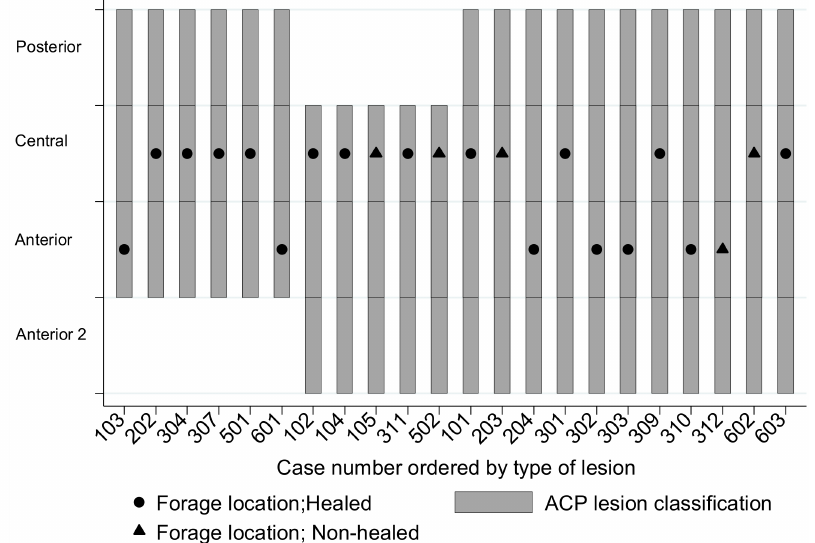
Figure 6. Case by case transverse location of the forage in the osteonecrotic (ON) lesion from anterior to posterior (ACP method described in Figures 3 and